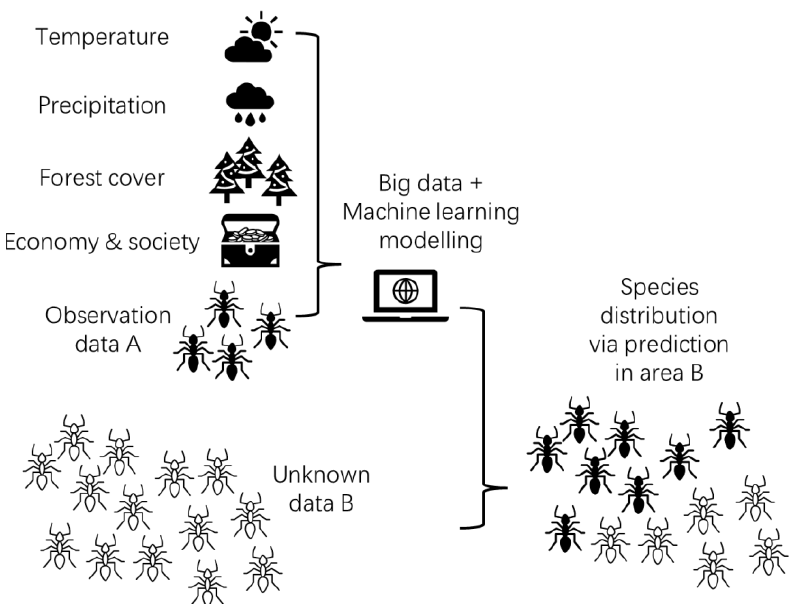
Figure 1. Framework showing how ML used the experimental data and predicted distribution of species richness in a region that had not yet been investigated. Temperature, precipitation, and forest cover have a significant effect on the distribution of species richness. The socioeconomic factors can affect the intensity of sampling ants.